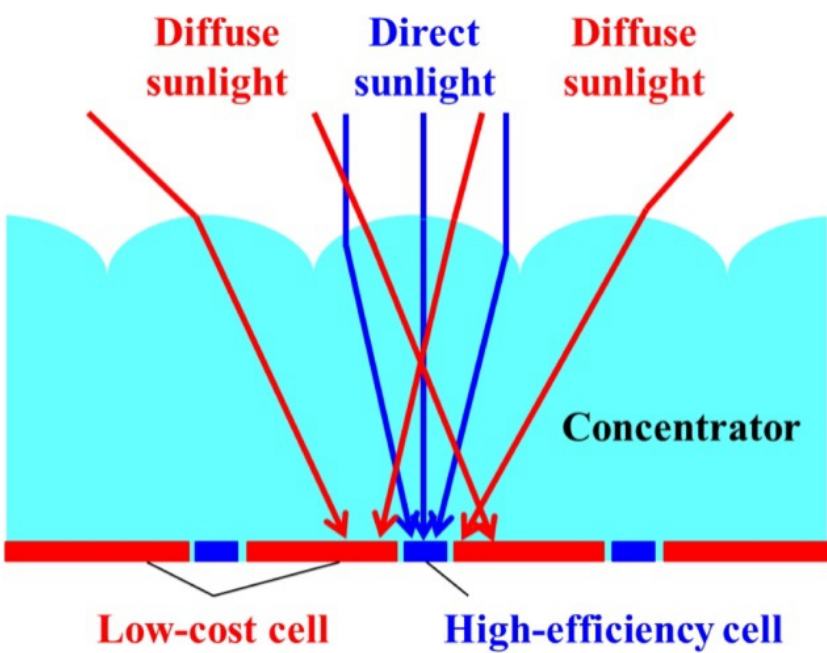
Figure 46. New concept of a CPV module [84]. Reprinted from N. Yamada et al.,